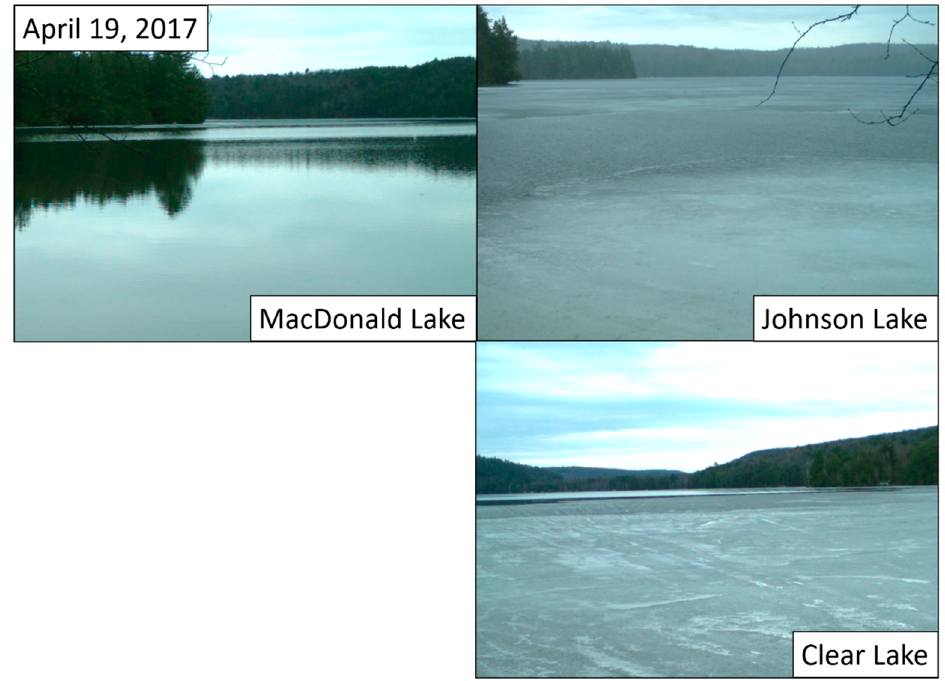
Figure 11. Comparison of ice surface conditions between the three primary study lakes on 19 April 2017.